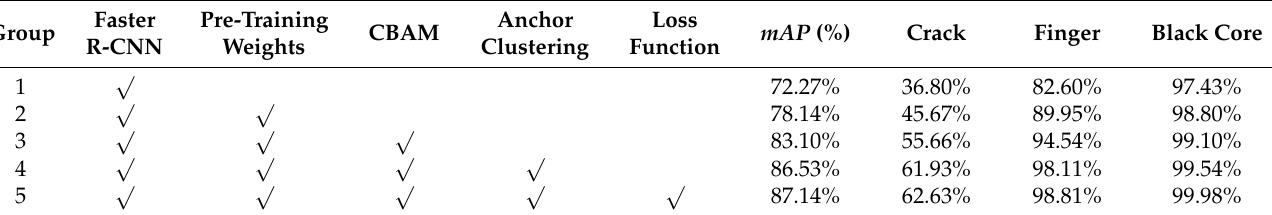
Table 3. Results of experiments with different improvement methods.